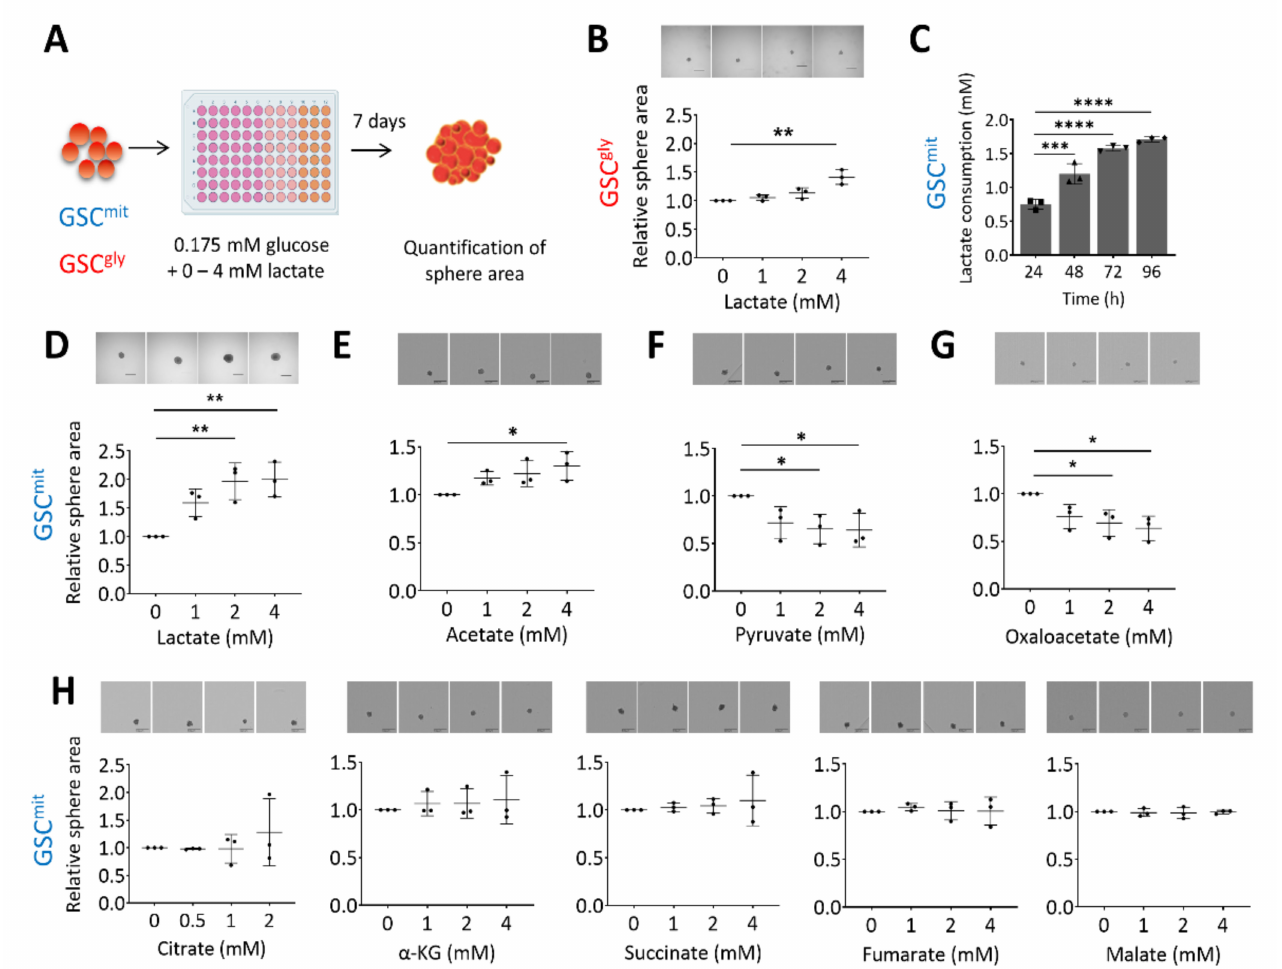
Figure 1. Lactate sustains the growth of oxidative GSCs during glucose deprivation. ( A ) Schematic representation of the experimental protocol. ( B ) Relative sphere growth for GSC gly (GSCA) cells cultured for 7 days in ultralow glucose medium (ULGM) supplemented with the indicated concentrations of lactate. Representative images of the spheres formed in each condition are also presented. Scale bars, 500 µ m. ( C ) Lactate consumption by GSC mit (GSCB) cells during culture for 96 h in ULGM containing 4 mM lactate. ( D – H ) Relative sphere growth for GSC mit cells cultured for 7 days in ULGM supplemented with the indicated concentrations of lactate ( D ), acetate ( E ), pyruvate ( F ), oxaloacetate ( G ), or citrate, α -ketoglutarate ( α -KG), succinate, fumarate, or malate ( H ). All data are means ± SD from three independent experiments and were evaluated by one-way analysis of variance (ANOVA) followed by Dunnett’s post hoc test. * p < 0.05, ** p < 0.01, *** p < 0.001, **** p < 0.0001. Scheme created with